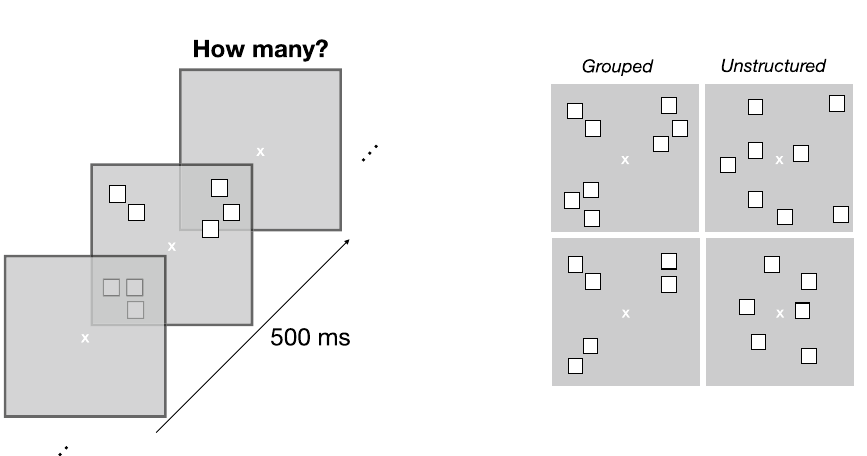
Figure 1. Stimuli and procedure. ( A ) Example of the time course of the experiment. Participants were asked to verbally report the number of the perceived numerosity. ( B ) Examples of stimuli arrangement for numerosity 8 and 6. Stimuli are not depicted to scale.